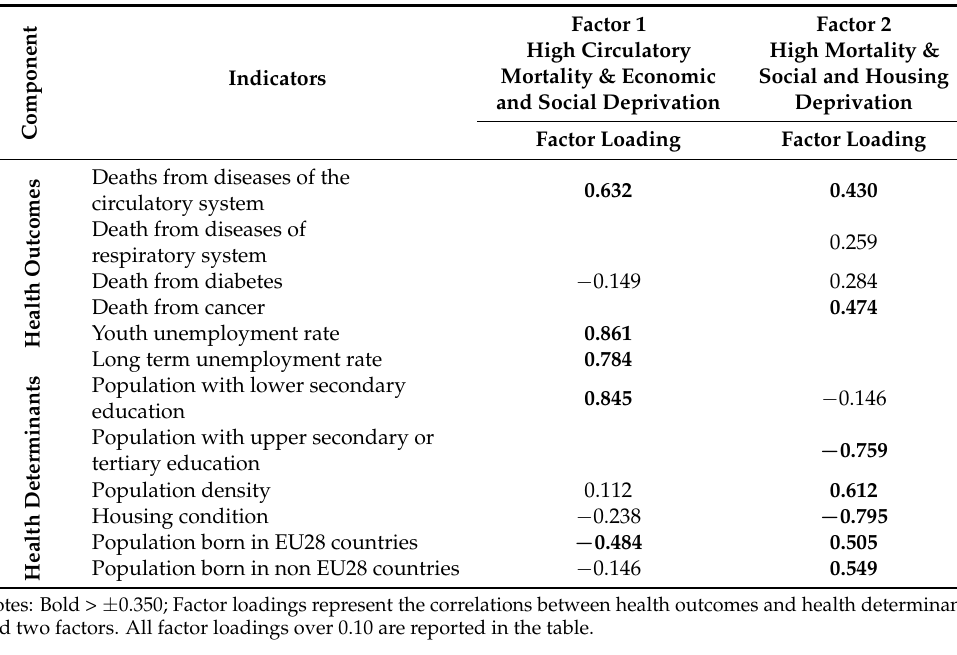
Table 4. Prague municipalities factor loadings.